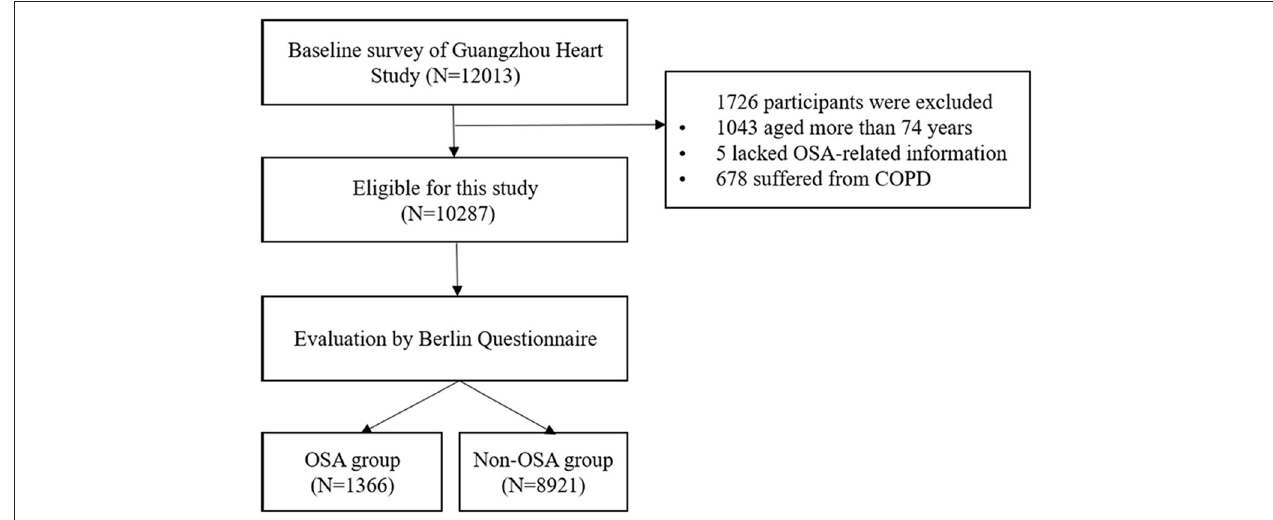
FIGURE 1 | Flow chart for the selection process of subjects.